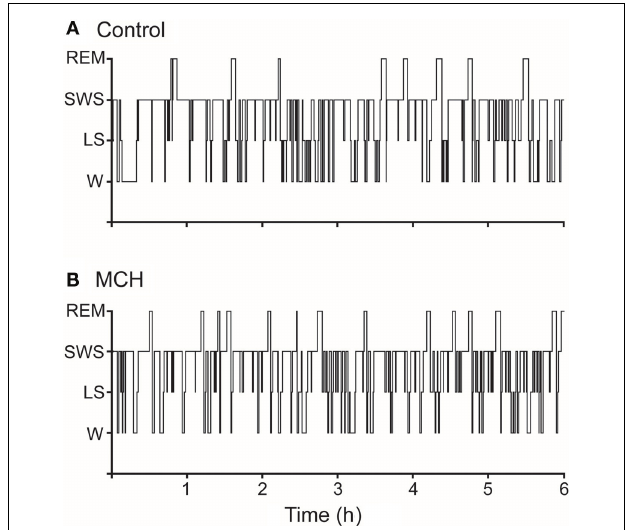
FIGURE 2 | Representative hypnograms illustrating the occurrence of wakefulness and sleep following microinjection of MCH into the dorsal raphe nucleus. The effects of the vehicle (A) , and 100ng of MCH (B) are presented. Comparing to control, the hypnogram corresponding MCH microinjection depicts a substantial increase in the number of REM sleep episodes.This figure was modified from Lagos et al. (2009).